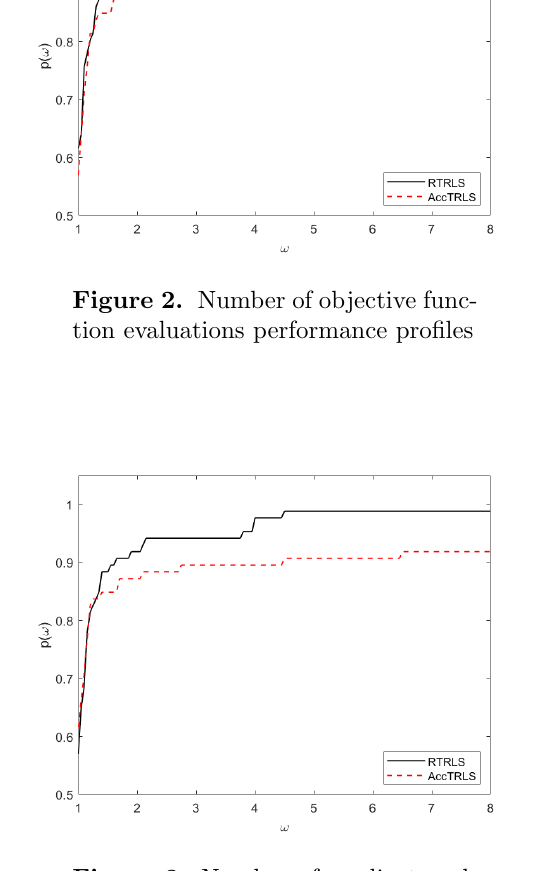
Figure 3. Number of gradient eval- uations performance profiles